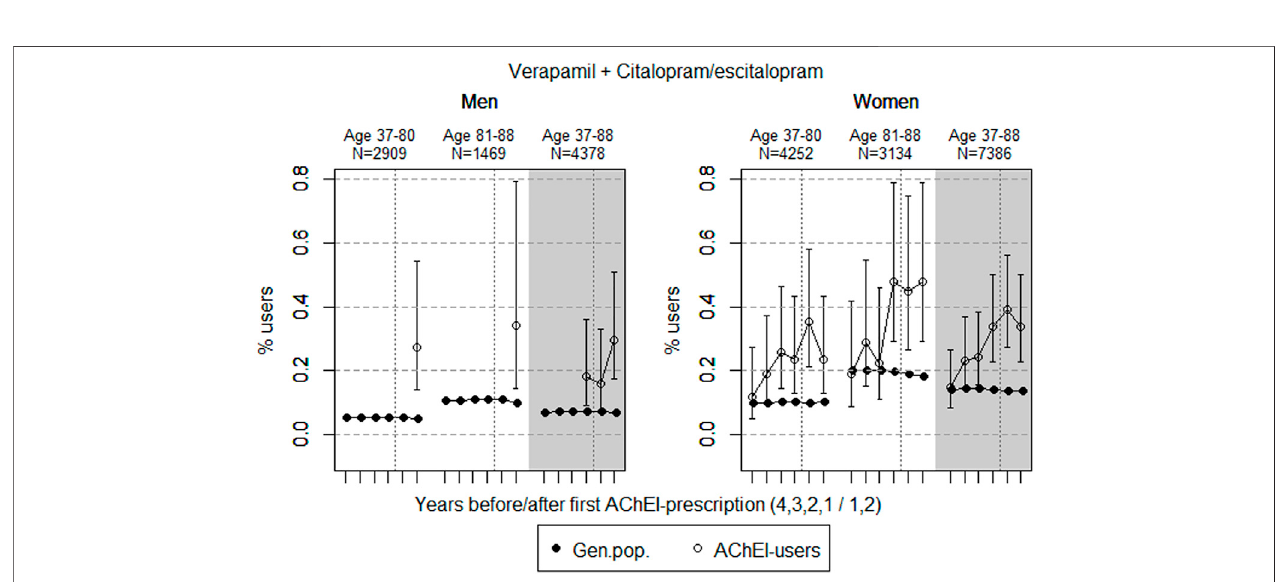
FIGURE6| Opencircles:Proportionofmenandwomen,respectively,ofthestudypopulationwhousedcombinationsofverapamilandcitalopram/escitalopramin the 4 years before AChEI initiation and the 2 years after with 95% con fi dence intervals. Years with less than fi ve users in one or both of the age groups are not shown. Bullets: The corresponding age adjusted proportion in the general population. Dashed vertical lines indicate AChEI initiation. The size of each age group in the study population is given on top.